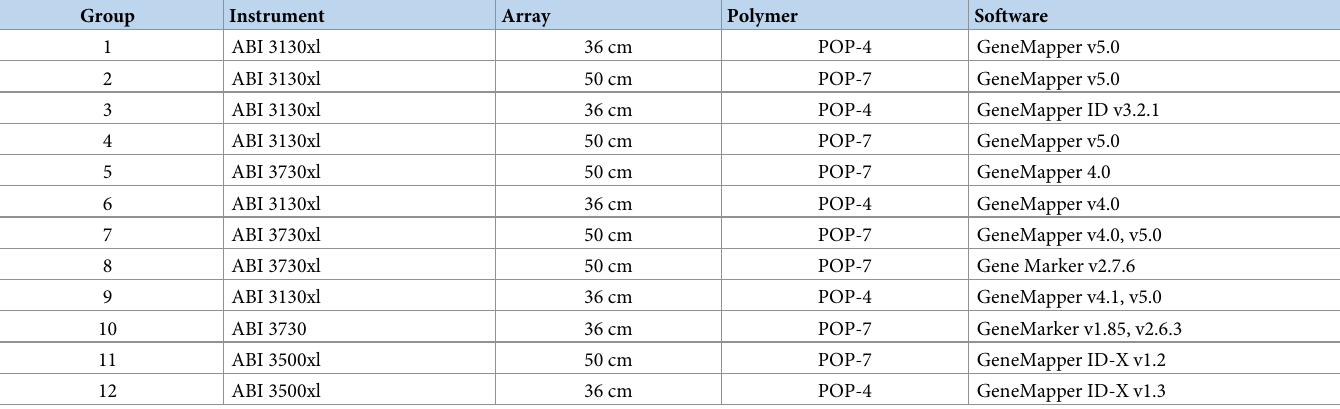
Table 3. Consortium laboratory member instrument, polymer, array, and software used in the interlaboratory study.